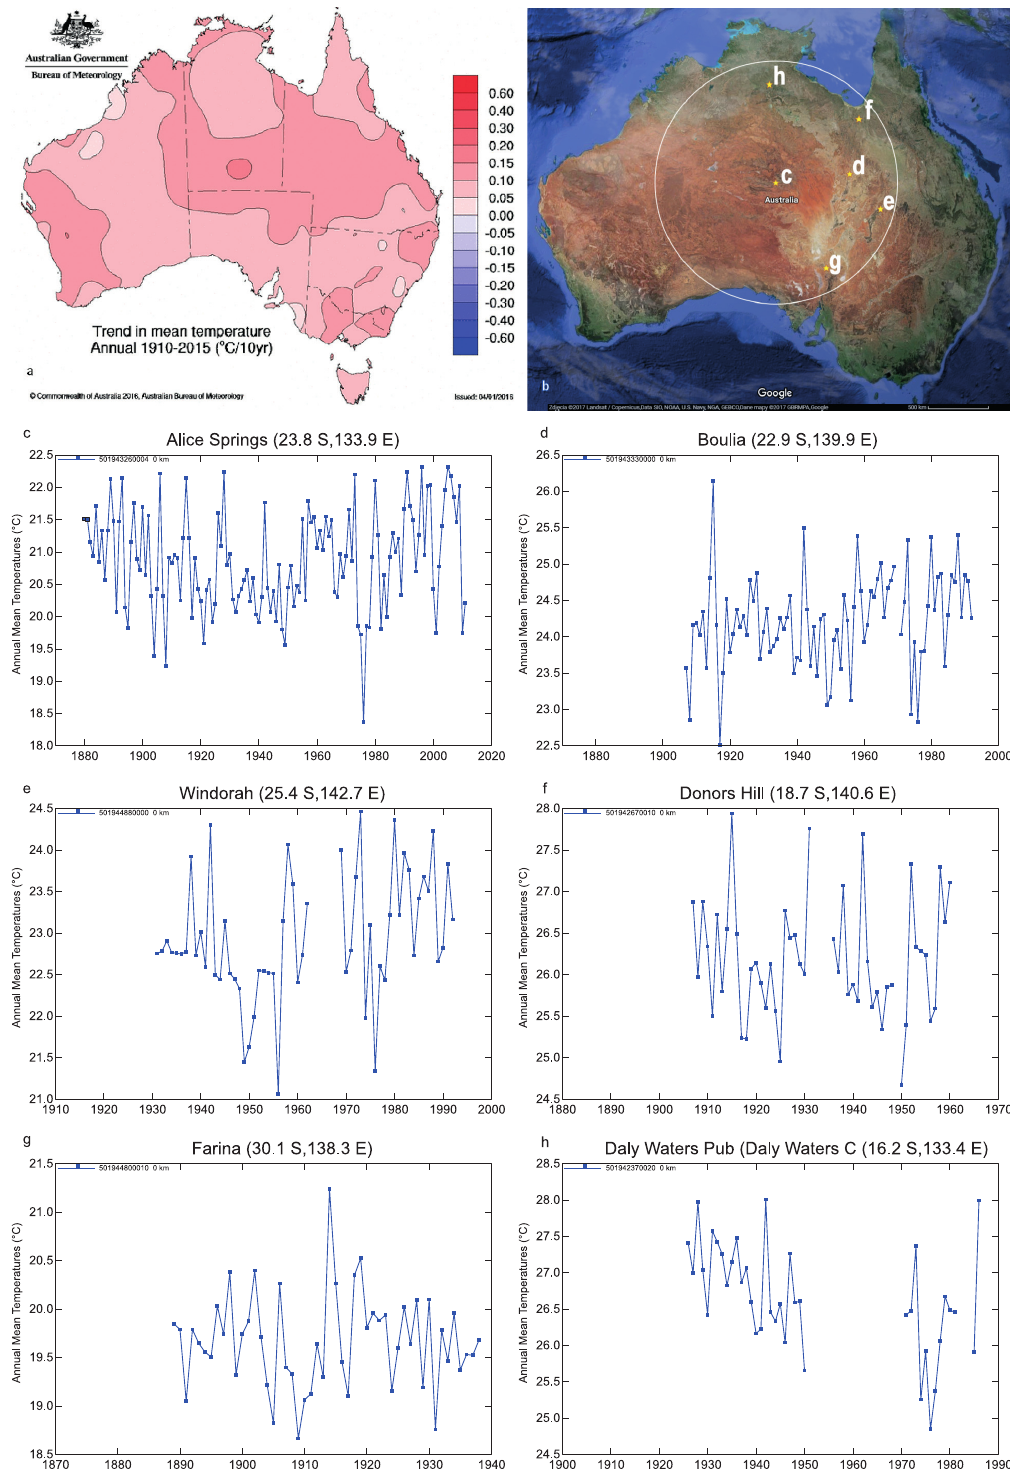
Fig. 6. a – Latest trend map 1910 to present by the Australian Government Bureau of Meteorology. (BOM 2017). The BOM suggest that at the center of Australia, around Alice Spring, there is a warming of up to 2 °C/century. b – the actually non-warming center of Australia within the radius of 1,000 km circle as still acknowledged in the Global Historical Climatology Network (GHCN) v.2 of October 2011. Some of selected individual temperature time series for the 37 stations within the Central Australia – the longest – are from GISS Surface Temperature Analysis (2017a): c – Alice Springs, d – Boulia, e – Windorah, f – Donors Hill, g – Farina, h – Daly Waters Pub. The BOM trend map is incompatible with the already massaged individual records of the GHCN v.2 (cf. Parker